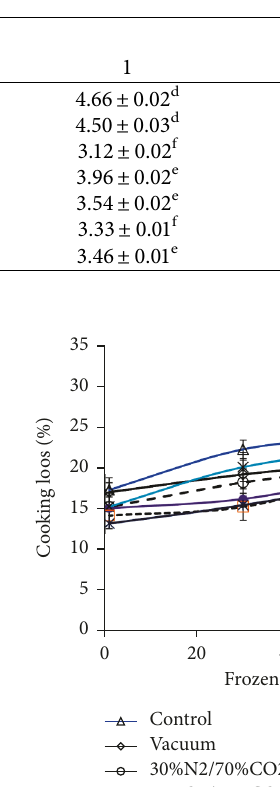
Table 3: Influence of MAP and FSP on drip loss (%) of CTMP.